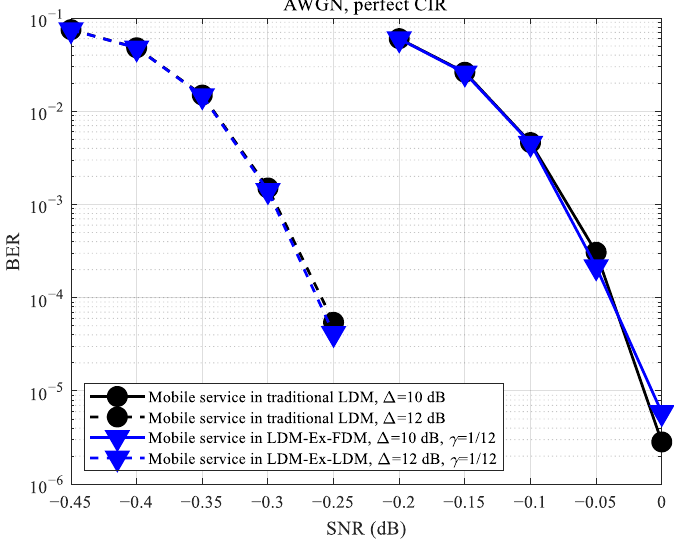
Figure 12. Bit error rate (BER) performance of mobile service in ATSC 3.0 system with and without LDM-Ex-FDM scheme with perfect channel impulse response (CIR) over the AWGN channel, where the parameters of the ATSC 3.0 system were set to ∆ = 10 and 12 dB, the CL constellation was set to QPSK, the EL constellation was set to NU − 64QAM, and the puncturing rate of the LDM-Ex-FDM scheme was set to 1/12.